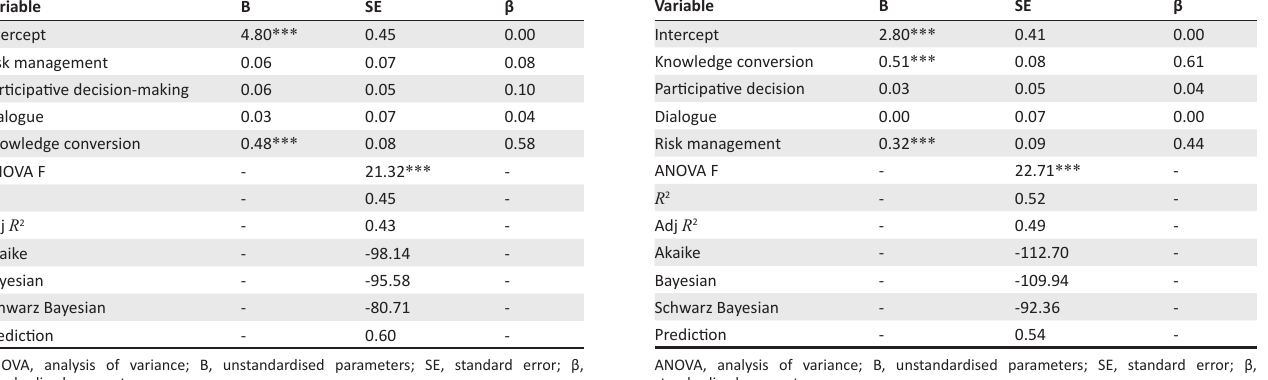
TABLE 3: Linear regression results for the effect of knowledge conversion on social innovation (Hypothesis 1). Variable